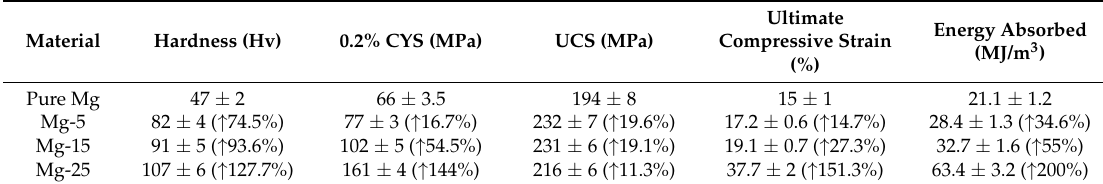
Table 2. Results of hardness and room temperature compression